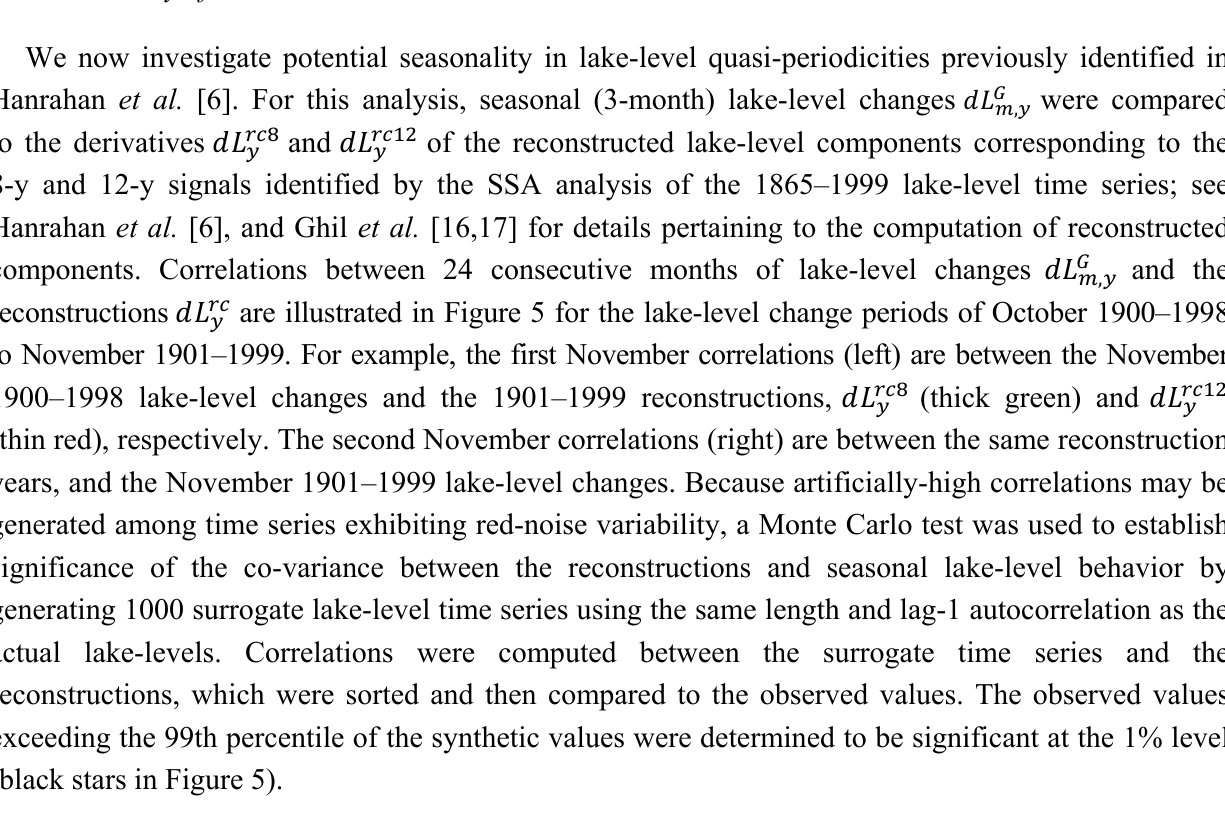
Figure 5. Correlation between the 8-y ( (cid:1856)(cid:1838) (cid:3052)(cid:3045)(cid:3030)(cid:2876) ; thick green) and 12-y ( (cid:1856)(cid:1838) (cid:3052)(cid:3045)(cid:3030)(cid:2869)(cid:2870) ; thin red) reconstructed lake-level changes, and the observed seasonal (3-month) lake-level changes ((cid:1856)(cid:1838) (cid:3040),(cid:3052)(cid:3008) ) . Black stars indicate correlations significant at the 1%